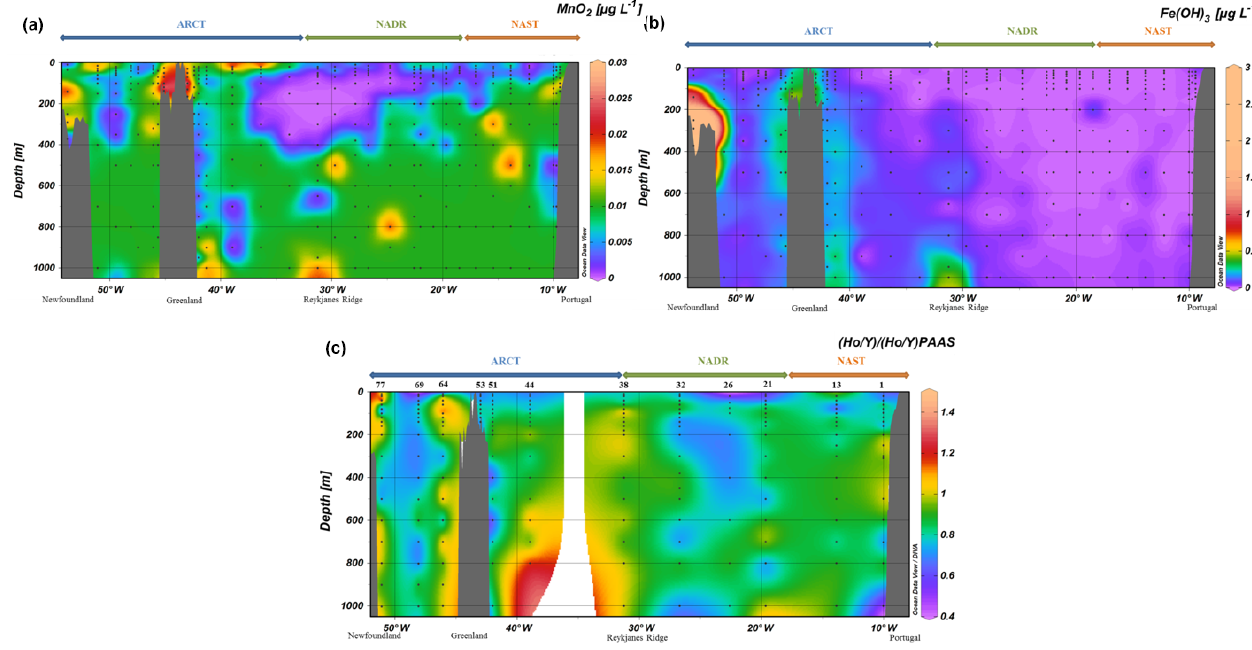
Figure 9. (a) MnO 2 and (b) Fe ( OH ) 3 concentrations (in µgL − 1 ) calculated with the formula proposed by Lam et al. (2017) using particulate Mn, Fe, and Al concentrations from Gourain et al. (2019). (c) PHo / PY normalized to